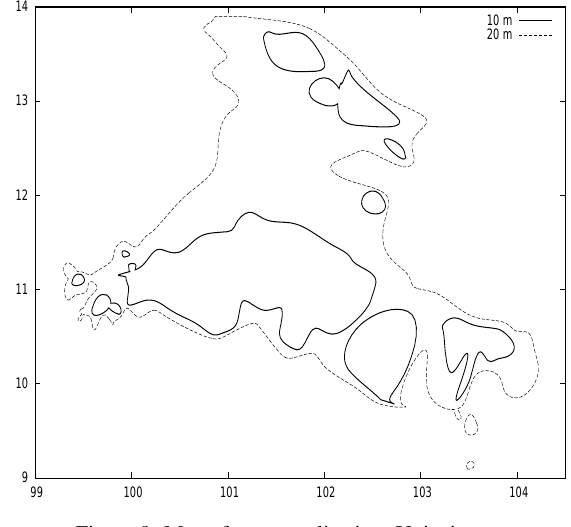
Figure 8: Map after generalisation. Units in